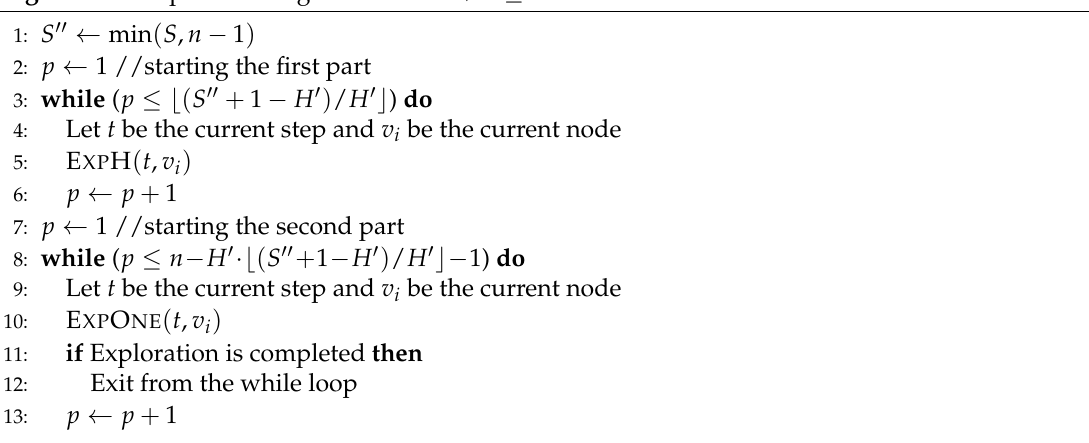
Algorithm 3 Exploration algorithm for H + S ≥